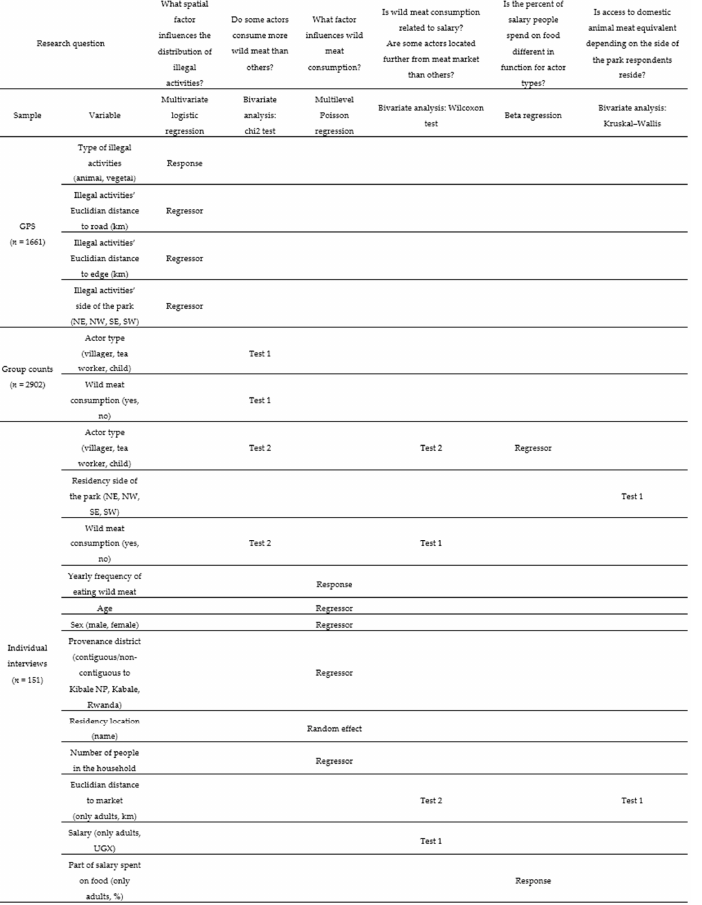
Figure A4. Variables used for illegal activity and wild meat consumption statistical modeling of key questions, Sebitoli area, Kibale National Park, Uganda.